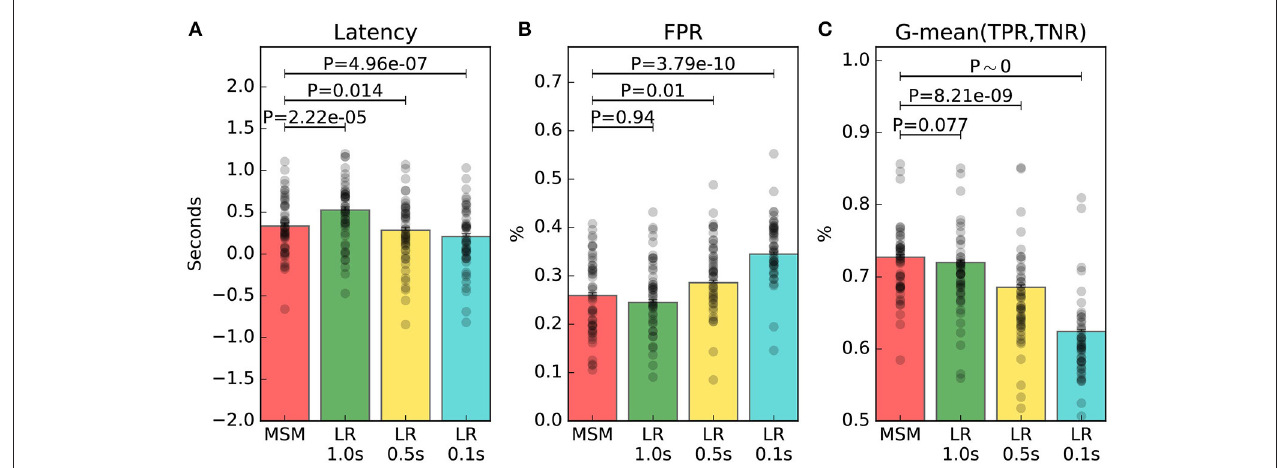
FIGURE 5 | Online performance measures of trials containing an ERD. The average measure of each individual is represented by a black dot. Panel (A) shows the latency of detection. Panel (B) shows the false positive rate (FPR). Panel (C) shows the geometric mean (G-mean) between true positive rate (TPR) and true negative rate (TNR). The significance of the multiple comparisons involving MSM are illustrated, while all the other comparisons are shown in Table 2 .